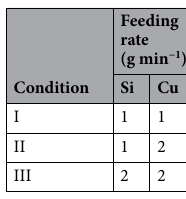
Table 1. Parameters used in the separate injection plasma flash evaporation experiment. Powder feeding rate of Si and Cu